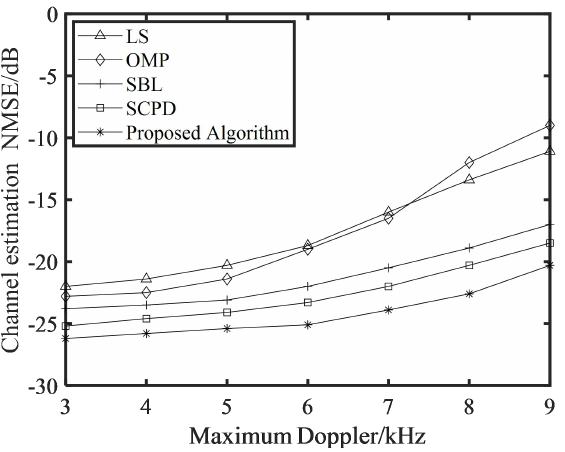
Figure 7. NMSE versus maximum Doppler shift f max . Simulation setup: the number of transmit antennas N R = 16, and the transmit RF chains M R = 16; the number of receive antennas N V = 4, and the receive RF chains M V = 4.The number of vehicles is 4, and the distance between vehicles is greater than 50 m.